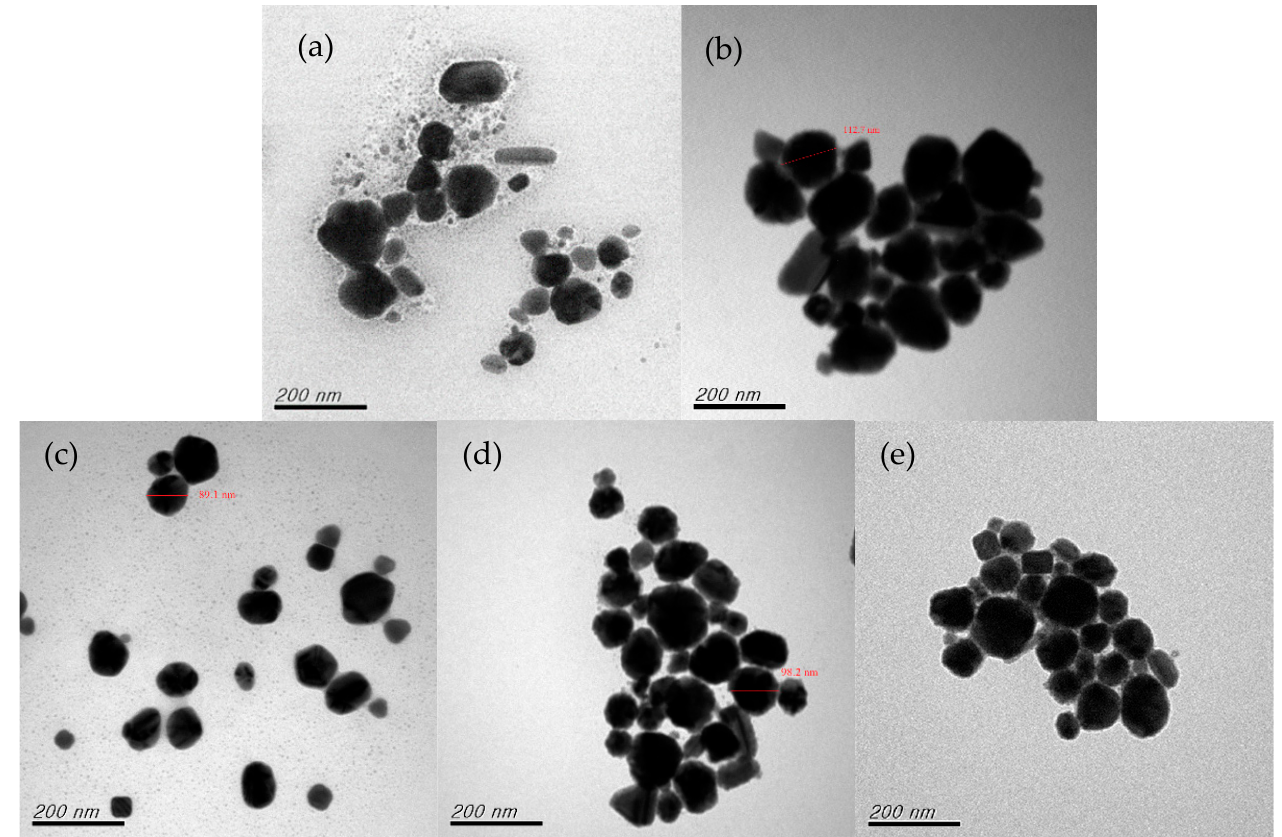
Figure 6. TEM images of CuNPs under secondary reduction at temperatures of ( a ) 65 °C, ( b ) 75 °C, ( c ) 80 °C, ( d ) 85 °C, and ( e ) 90 °C.